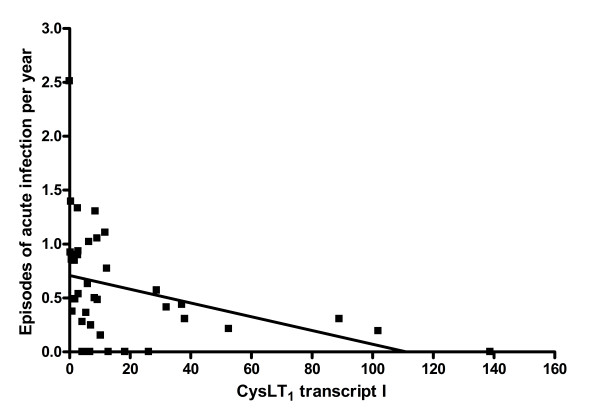
Correlation of CysLT1 transcript I relative expression with the episodes of acute infection in the whole asthmatic population. Spearman's rank correlation coefficient was R = - 0.52, pcor = 0.0009.